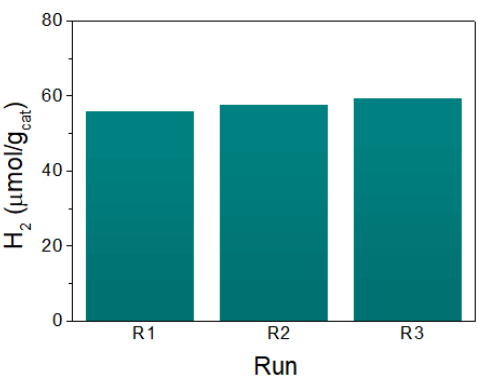
Figure 8. Recycling of the (TBA) 2 Mo 6 I i8 @GO catalyst in the photochemical H 2 production from water in vapor phase after 16 h of in vapor phase after 16 h of radiation.